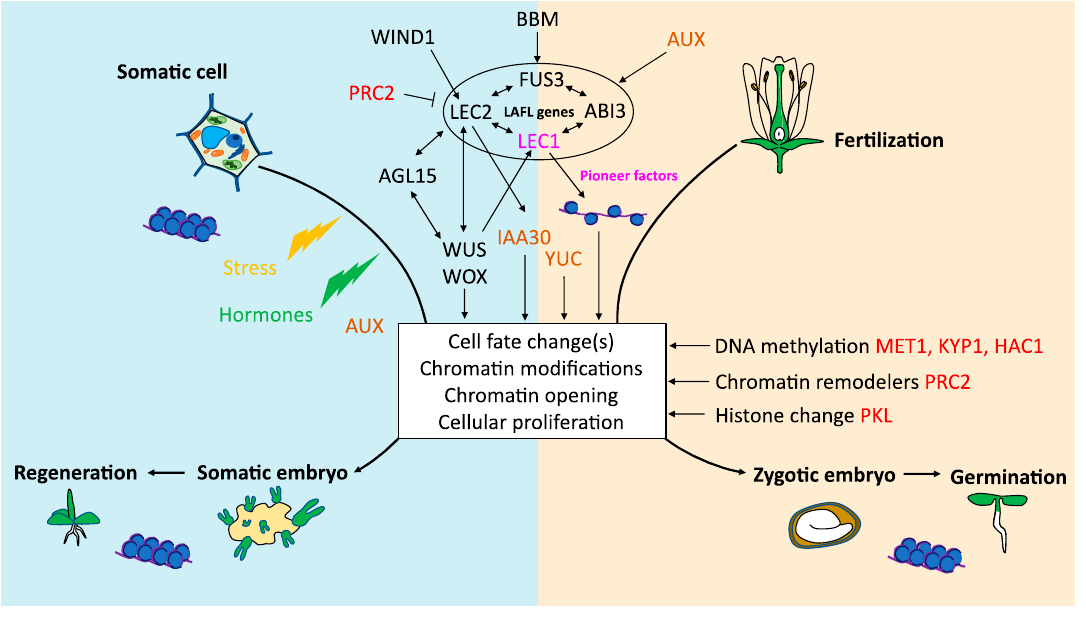
Figure 3. General overview of genes involved in somatic embryogenesis or zygotic embryogenesis in interaction with LEC1, ABI3, FUS3, and LEC2 (LAFL) transcription factors. Hormone-related genes are represented in brown, epigenetic regulators in red, transcription factors in black and pioneer factors in bright pink.